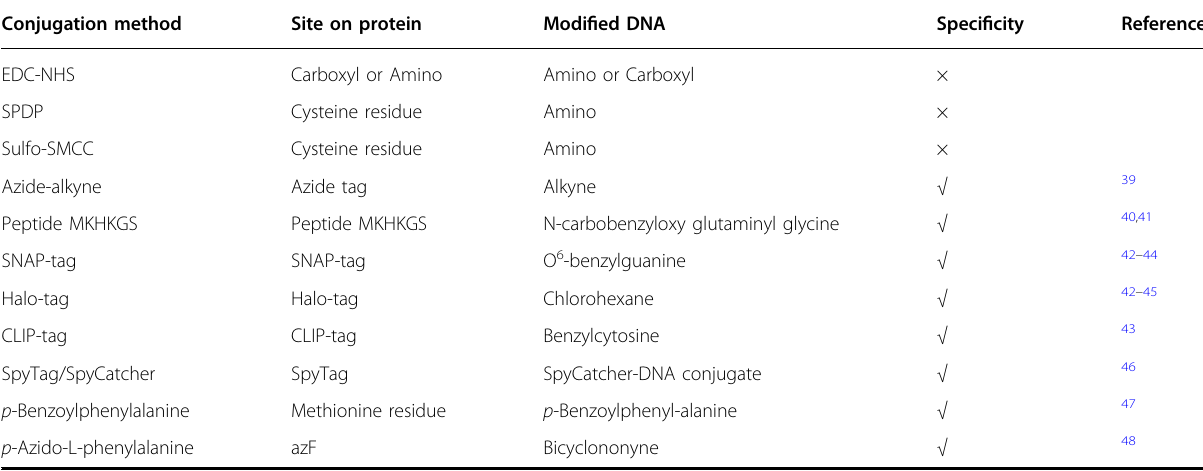
Table 1 Representative examples of covalent DNA – protein